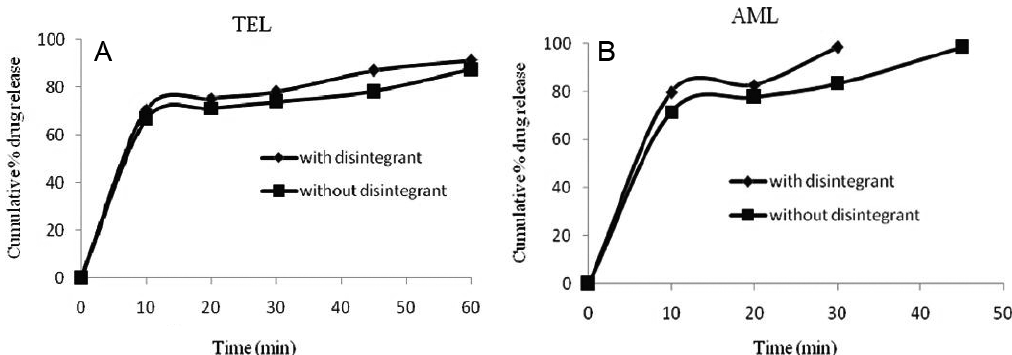
FIGURE 5- Comparison of dissolution profiles of TEL/AML tablets manufactured with and without a disintegrant.(A) Profile for TEL and (B) for